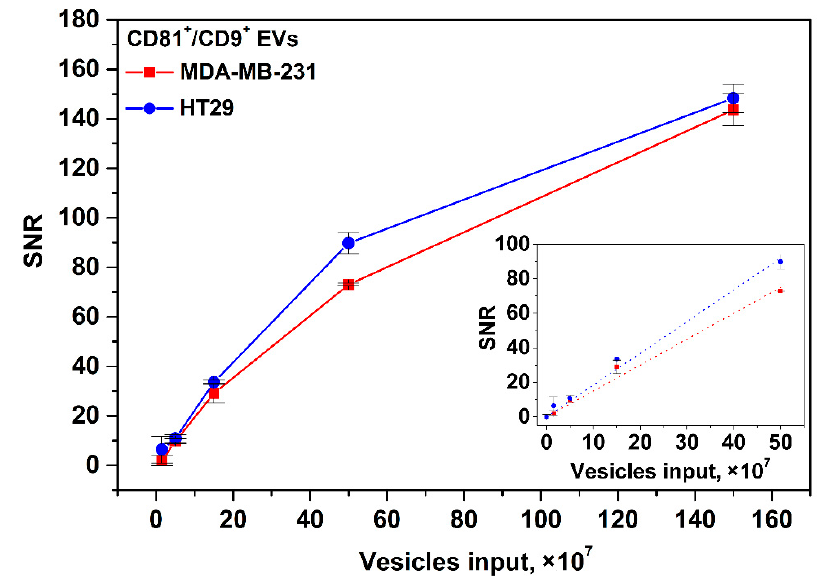
Figure 5. Calibration plots for CD81 + /CD9 + HT29 and MDA-MB-231 EVs. Insert: zoomed linear fitting plots for low EV input range.